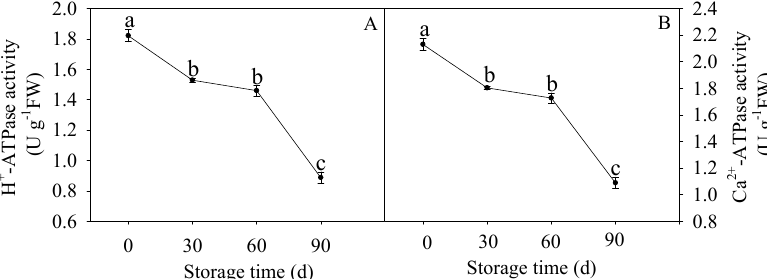
Figure 3. Changes in H + -ATPase ( A ) and Ca 2 + -ATPase ( B ) activities in postharvest pumelos during storage at 25 ◦ C. Each data point was shown as the mean ± standard error (SE). Di ff erent letters indicated significant di ff erence ( p < 0.05).